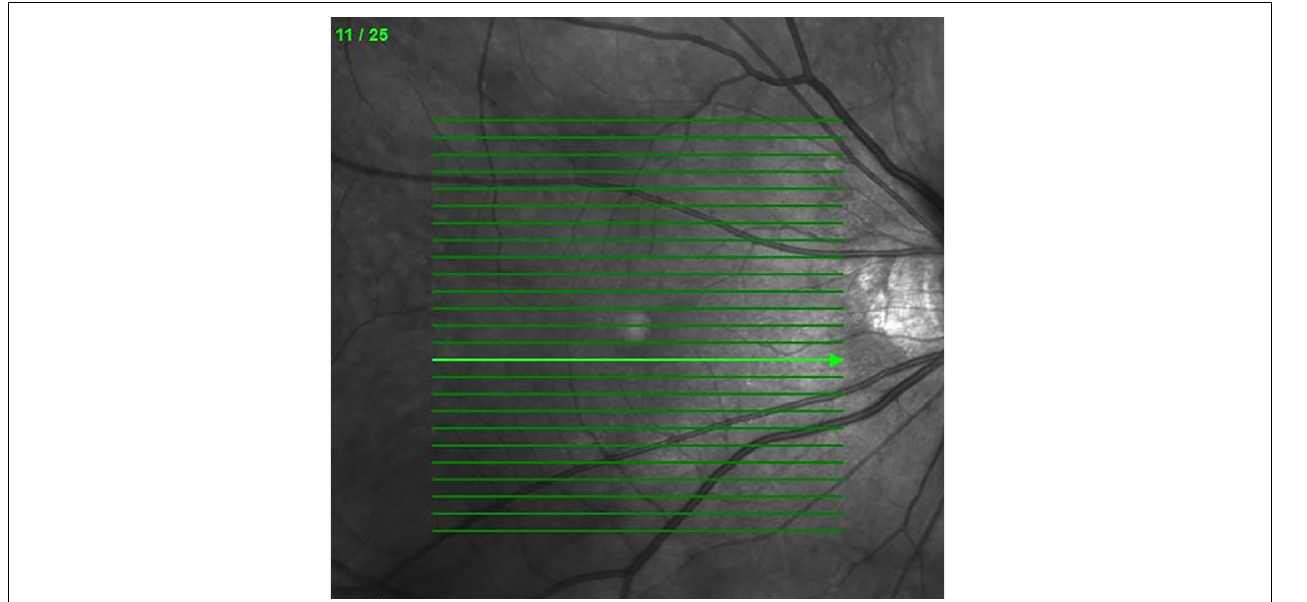
FIGURE 1 | The 25 6-mm radial scans across the retina centered on the fovea in SD-OCT.